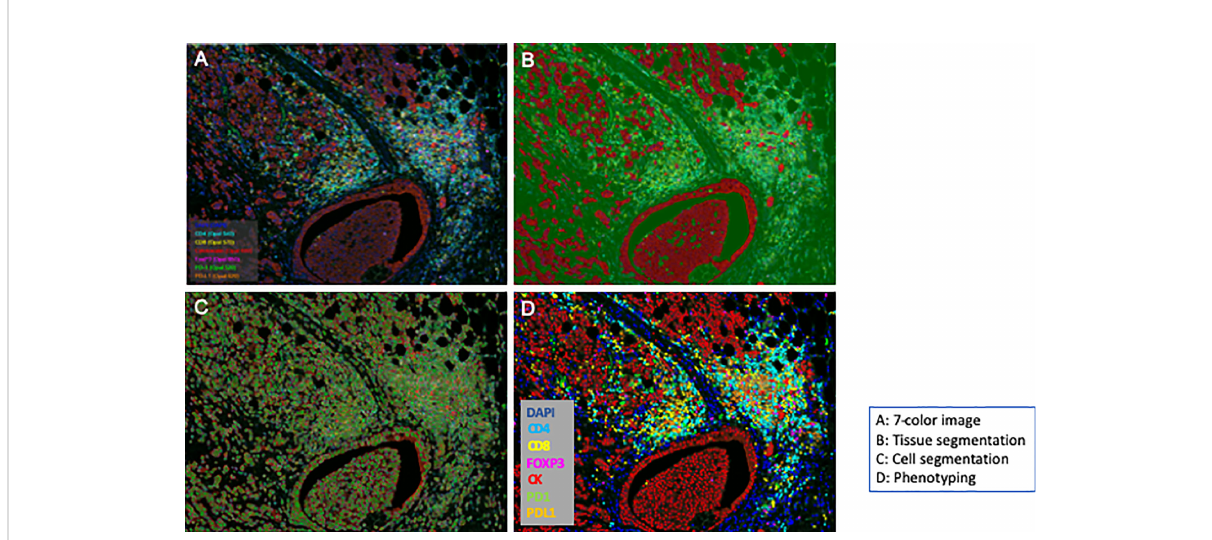
FIGURE 1 Work fl ow of an automated multispectral imaging system. Fluorescence multiplexed immunohistochemistry and merged images. Whole section was segmented based on the expression of cytokeratin (segmentation); each image was captured (cell detection) and unmixed spectrally to quantify each marker